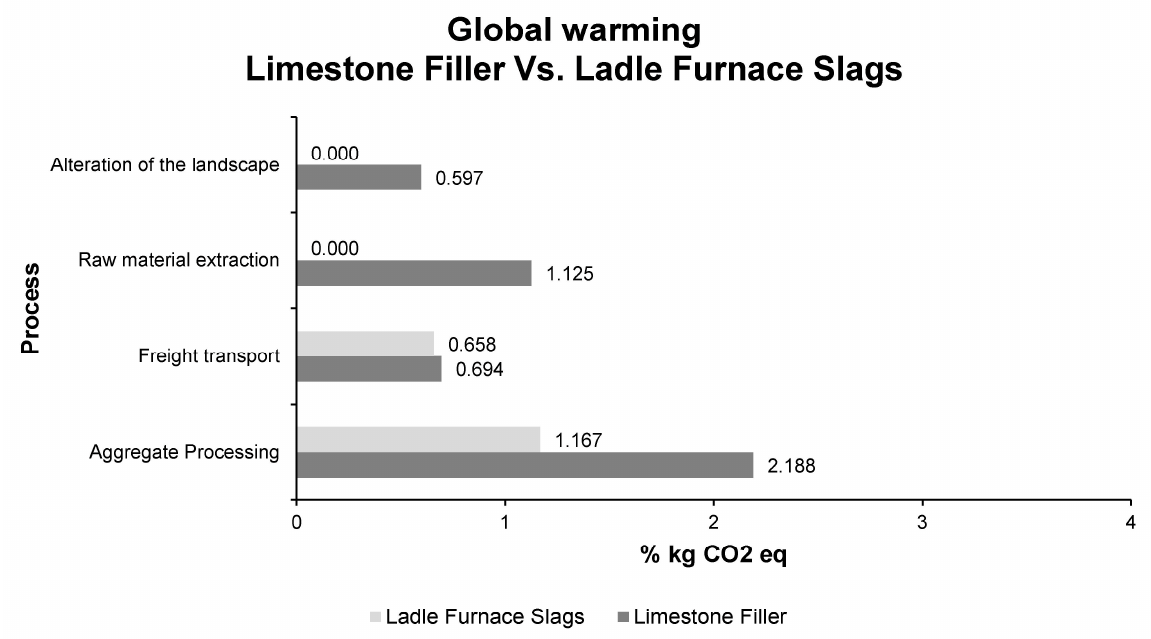
Figure 5. Global warming emissions in kilograms of CO 2 equivalent for ladle furnace slag and commercial limestone filler.